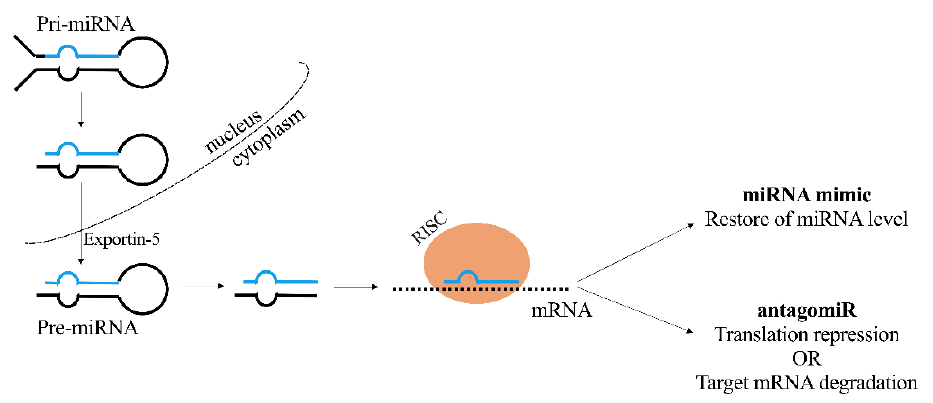
Figure 3. Mechanism of action of therapeutic miRNA. miRNA: microRNA; RISC: RNA-induced silencing complex; antagomiR: anti-miRNA; mRNA: messenger RNA.